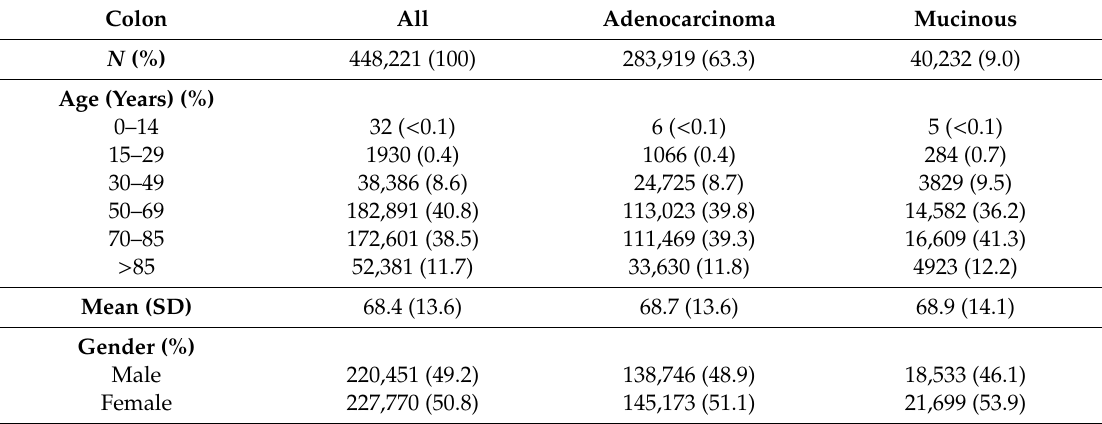
Table 1. Baseline demographics and clinical characteristics by histology for colon cancers .